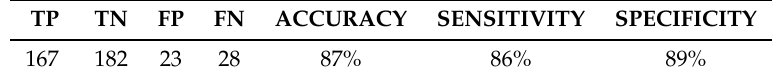
Test results: RMS likelihood algorithm compared to the VIS method (used as the reference